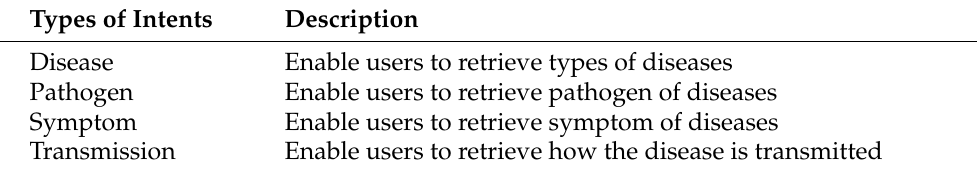
Table 1. Intents in